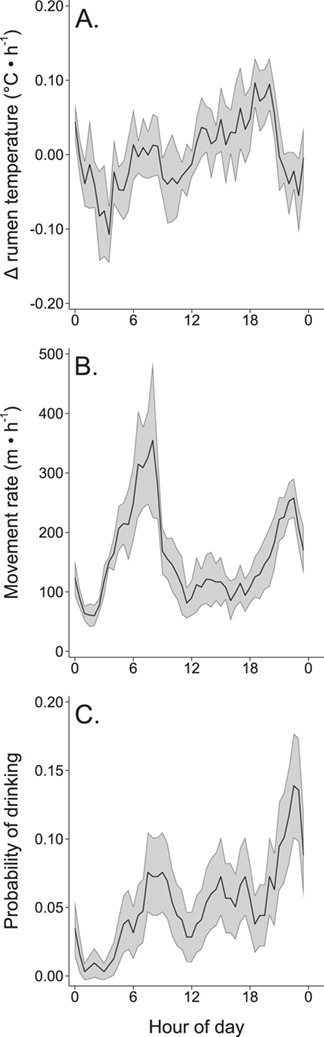
Daily patterns of (A) rate of change in rumen temperature (°C • h−1), (B) movement rate (m • h−1) and (C) probability of drinking for captive adult female moose (n = 6) at the Kenai Moose Research Center, Kenai Peninsula, Alaska, USA from May through August 2015. Predicted values with 95% confidence intervals from (A, B) mixed-effect regression and (C) mixed-effect logistic model regression against time of day (0.5 h time periods starting at 0:00). Daily sunrise (04:34–06:56) and sunset (21:13–23:39) varied over the summer.